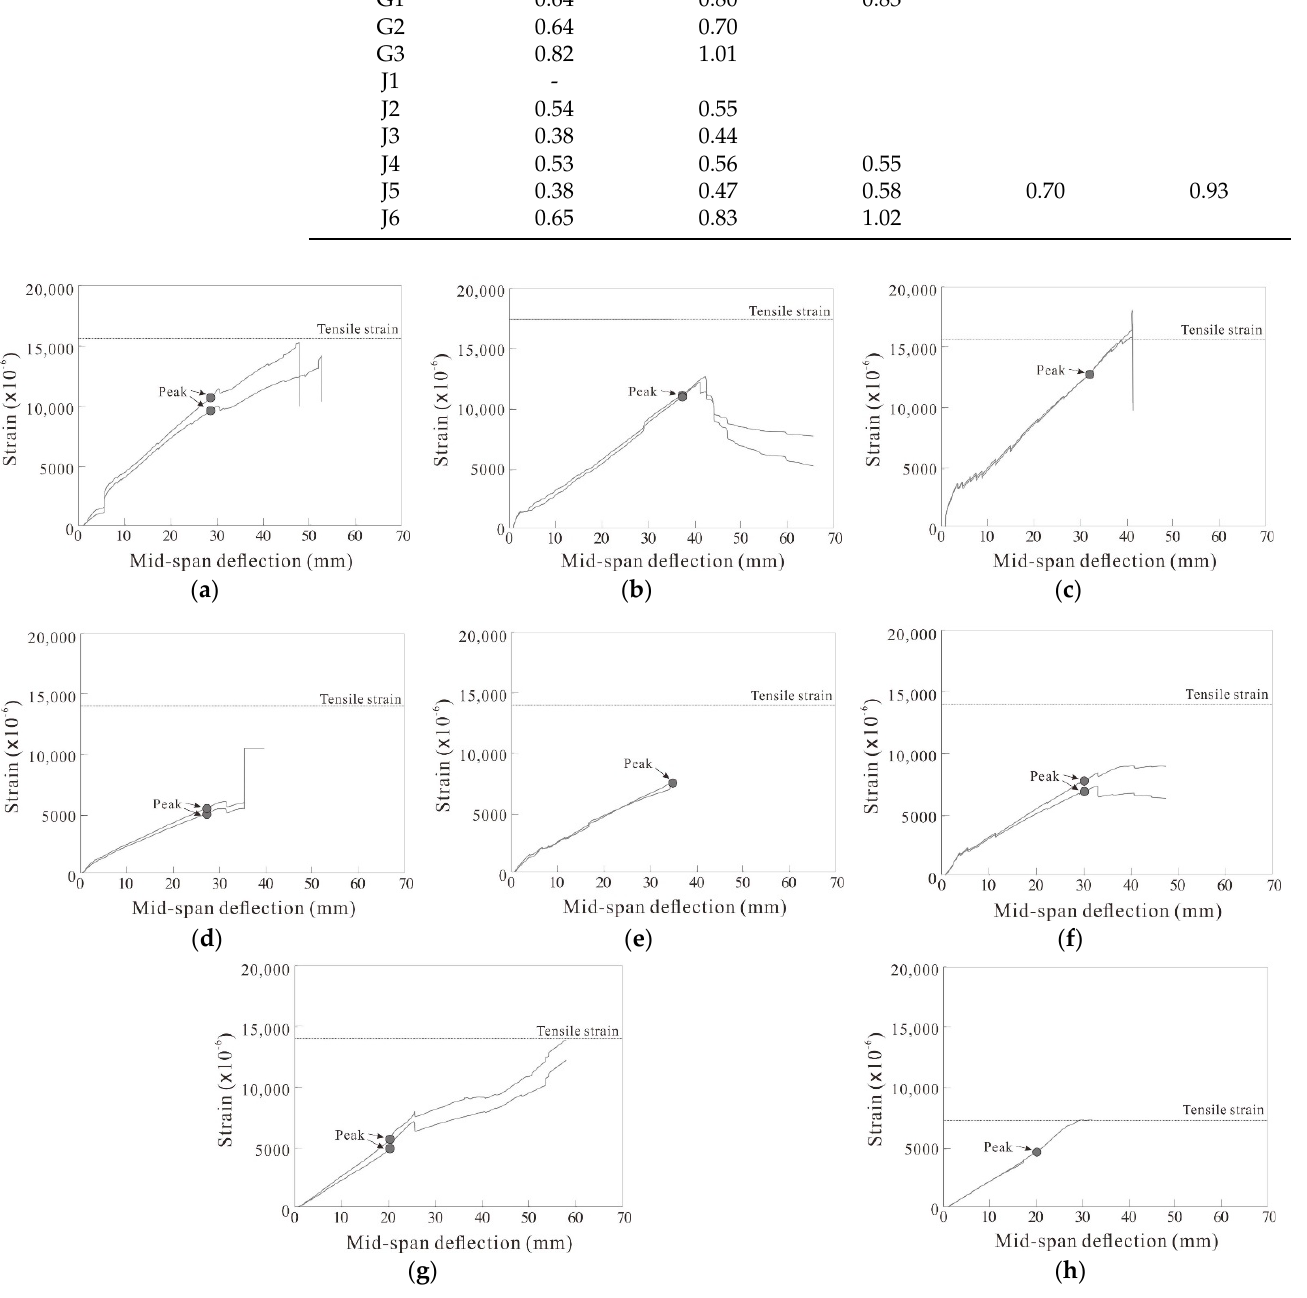
Table 8. Ratios of strain to tensile strain.